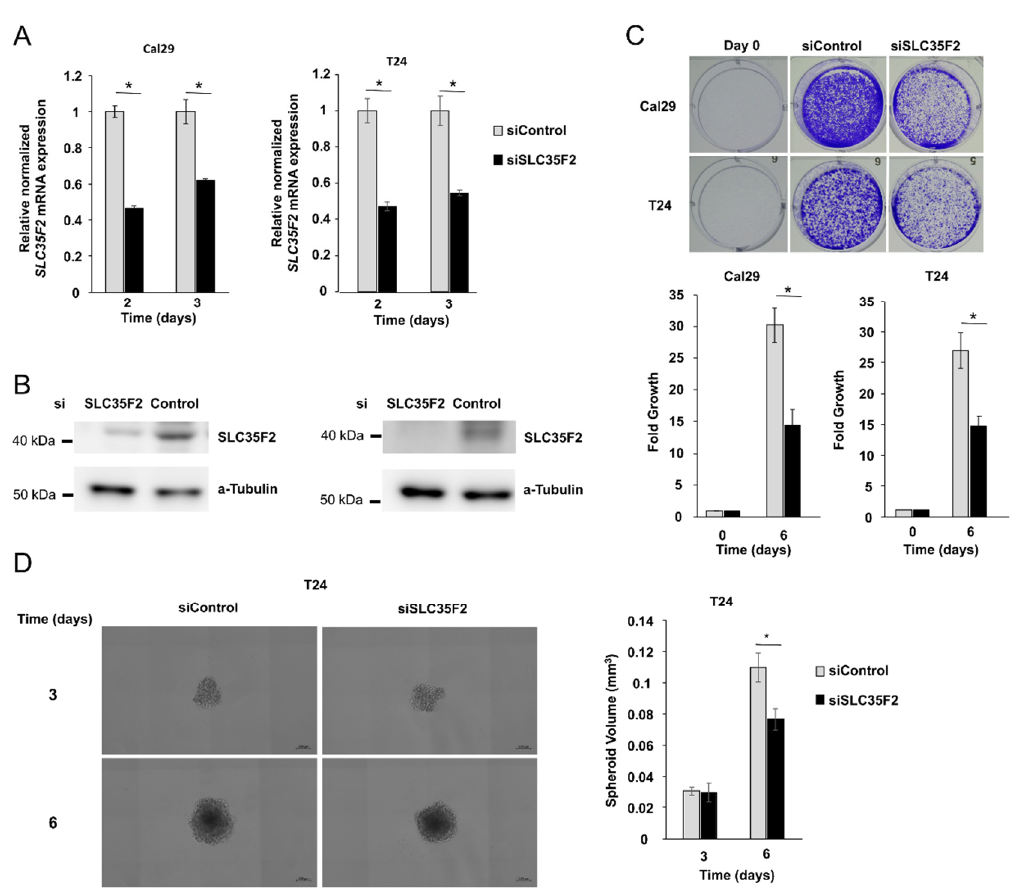
Figure 4. SLC35F2-dependent growth in Cal29 and T24 bladder cancer cells. Knockdown of SLC35F2 by siRNA leads to a decrease in mRNA expression ( n = 4) ( A ) as well as protein expression ( B ) (for full image, see Supplementary Figure S2) in Cal29 and T24. Cell growth is significantly reduced in SLC35F2 knockdown cells, analysed by crystal violet staining assay ( n = 4) ( C ). Spheroid growth of T24 is also significantly reduced after six days ( n = 6) ( D ). * p < 0.05 Mann–Whitney-U test.